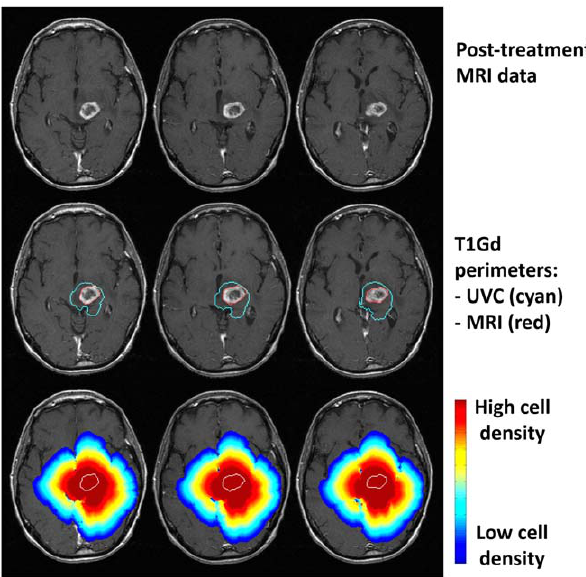
Figure 2. Comparisons between T1Gd MRI data and untreated virtual control (UVC) prediction at post-treatment time point. Patient was 58 years old and underwent biopsy followed by conformal radiation therapy with concurrent temozolomide chemotherapy. Top row: MRI data. Middle row: Actual tumor perimeter (red) with superimposed UVC-predicted tumor perimeter (cyan). Bottom row: full distribution of UVC cell densities showing invasion peripheral to abnormality. Outermost blue cell density profile represents a very low, but non-zero, threshold. Perimeter of actual tumor outlined in white. doi:10.1371/journal.pone.0051951.g002 identify the tumor region with a polygon of interest, and an automated edge detection algorithm selects the imaging abnor- mality within the enclosed area.